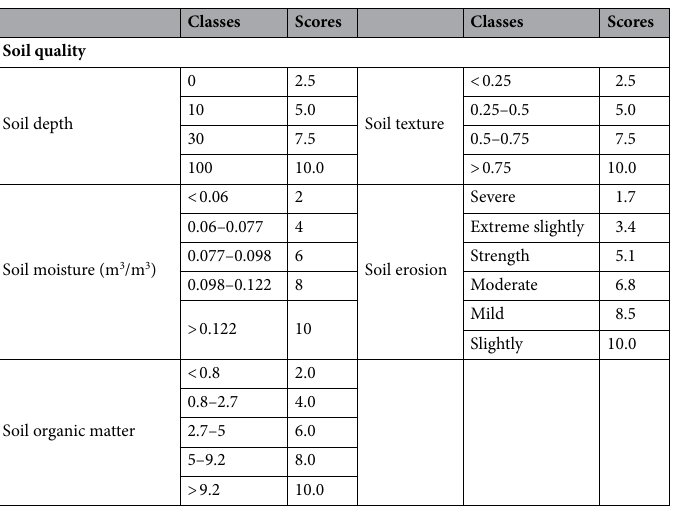
Table 4. The scores of various indexes of soil quality in the QTP.